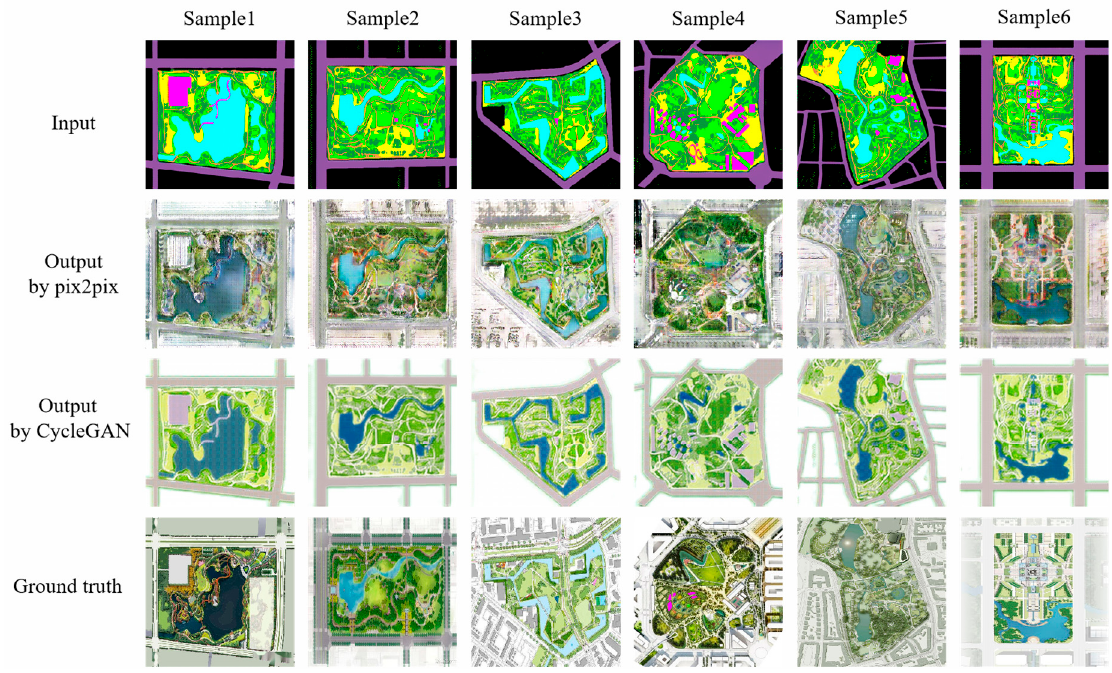
Figure 16. Plan generation experimental results.